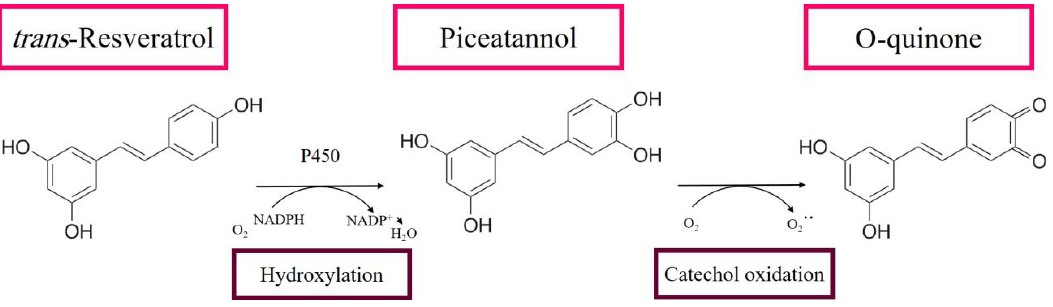
Figure 2. Metabolism of resveratrol in the liver.